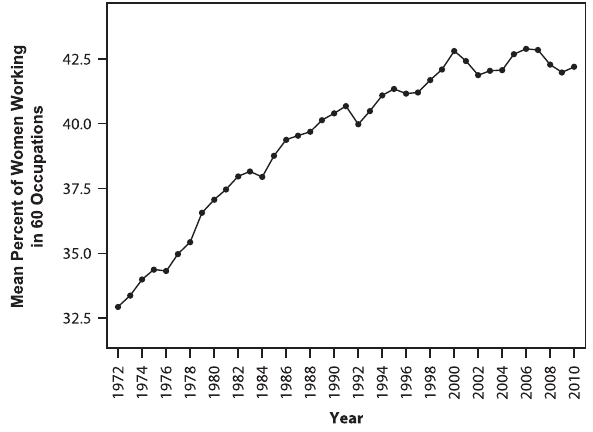
Figure 1. Mean percent of women working in 60 occupations as a function of